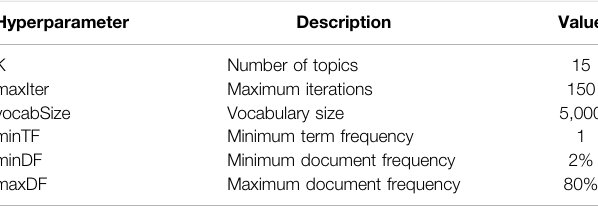
TABLE 3 | Best LDA hyperparameters obtained for a monthly analysis of news